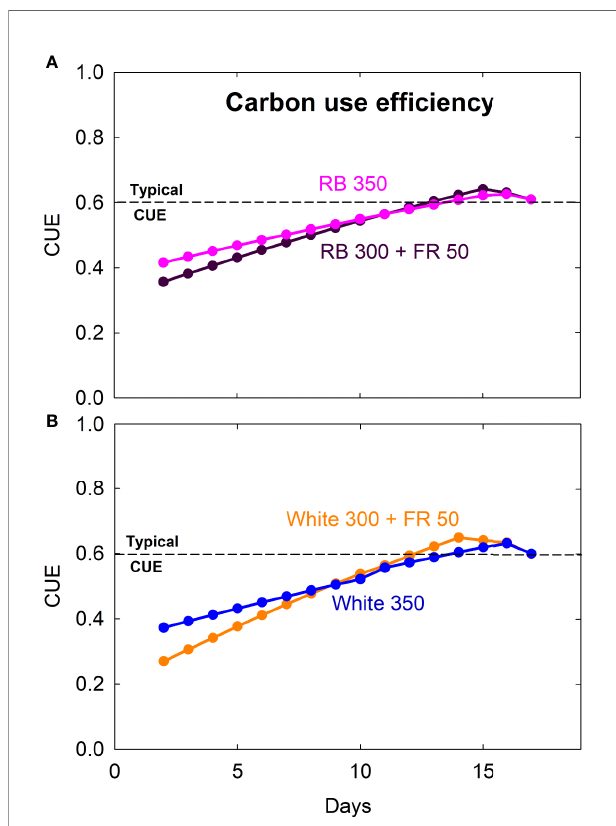
FIGURE 4 | Carbon use ef fi ciency (CUE = daily carbon gain ÷ gross photosynthesis) of lettuce grown under red/blue (RB) and white light, with or without far-red (FR) substitution. The numbers following each type of light ( e.g. RB 350) indicate photon fl ux density in m mol m − 2 s − 1 . Dashed lines indicate a typical CUE value of 0.6 that has been reported for mature